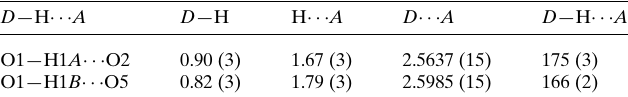
Table 1 Hydrogen-bond geometry (A˚ , (cid:4) ).